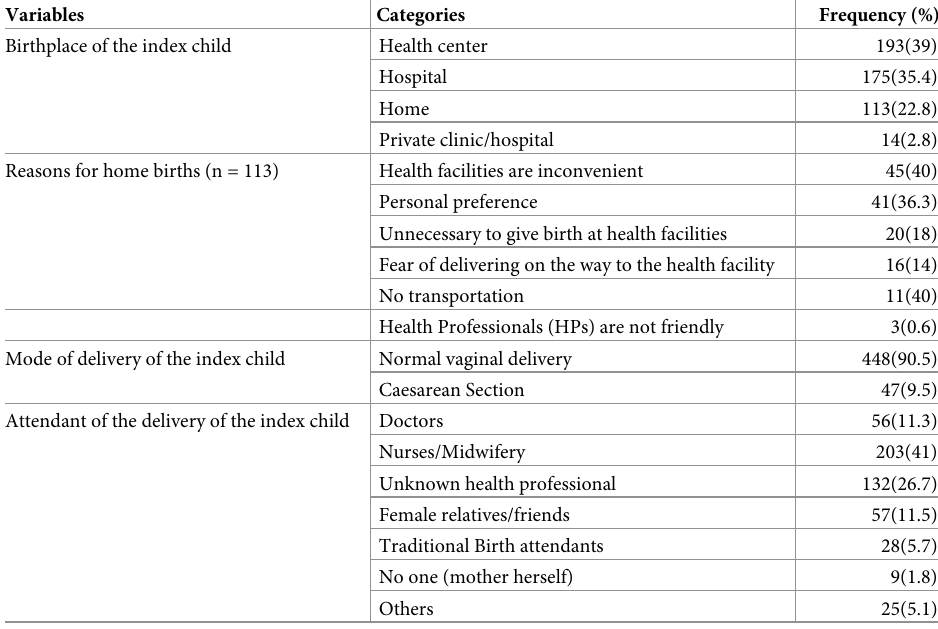
Table 2. Delivery characteristic of participants at KMC implementation sites, Sidama Administration, 2018.